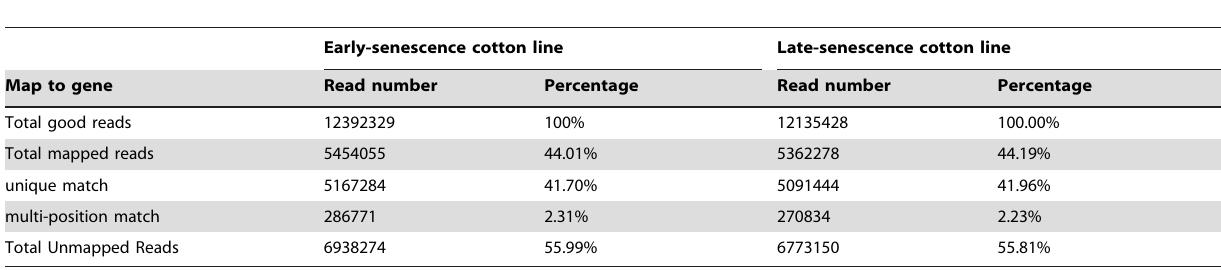
Table 1. Total number of sequencing reads obtained from each